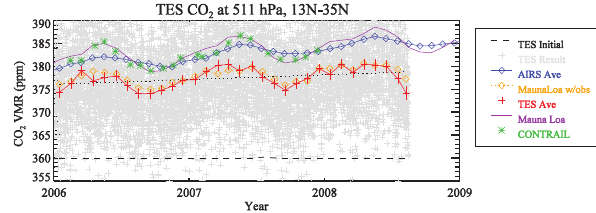
Figure 8 Fig. 8. TES CO 2 retrieved with an initial guess and prior (dashed line) of 360ppm for (13-35 ◦ N, 128-158 ◦ E). The TES results (red) agree well with Mauna Loa data with the TES observation operator (orange) applied, which accounts for TES sensitivity. This validates the TES reported sensitivity, which is captured in the averaging ker-